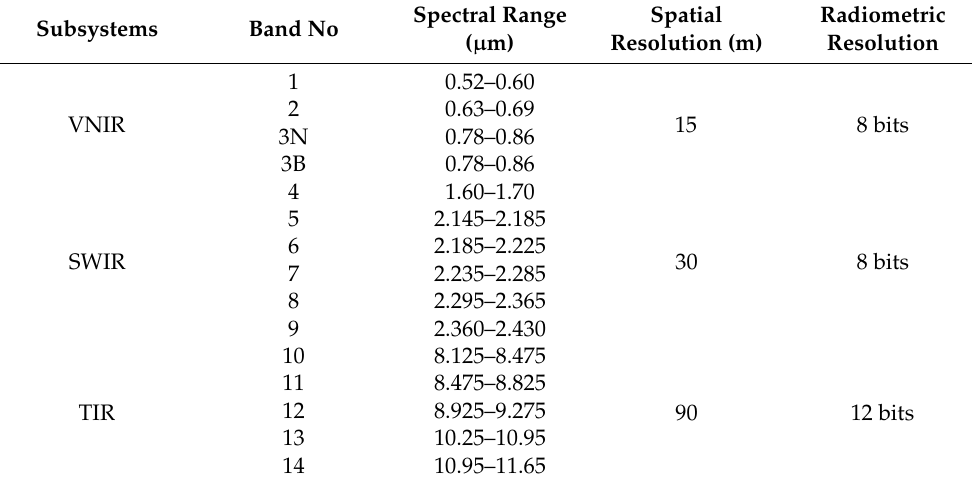
Table 1. Details of ASTER sensor imagery based on